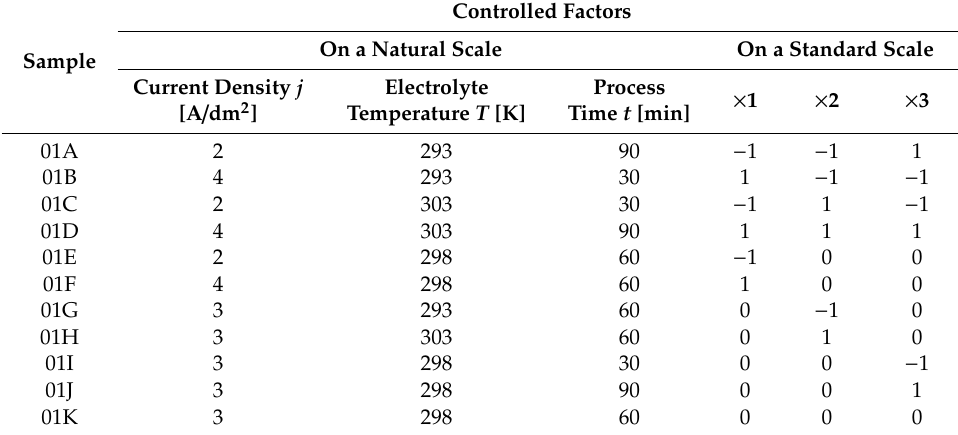
Table 1. List of factors on natural and standard scale for coatings produced in anodizing process without thermo-chemical treatment.